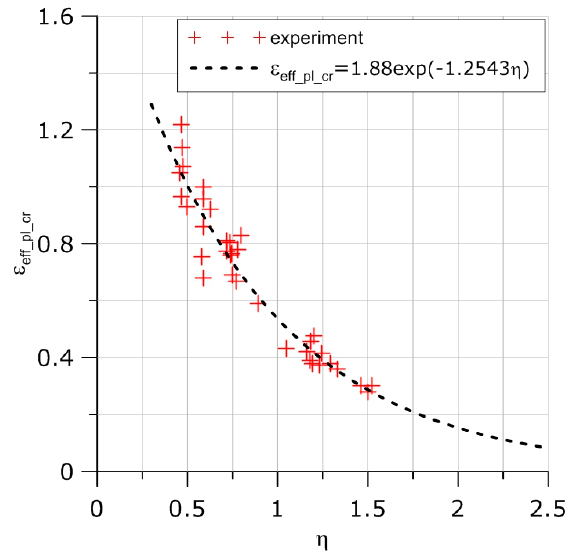
Figure 8. Exponential dependence between the critical strain and the triaxiality factor.